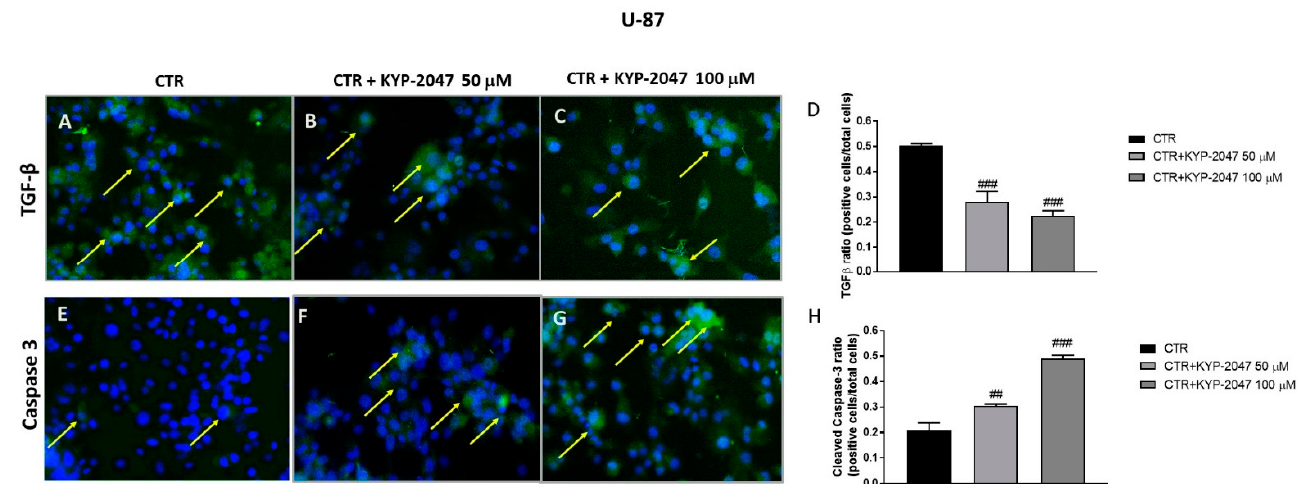
Figure 9. Effect of KYP-2047 on transforming growth factor- β (TGF- β ) and caspase-3 expression in U-87 cells. Immunofluo- rescence assay performed on U-87 cells revealed a marked expression of TGF- β in the control group ( A ), while the treatment with KYP-2047 at the concentrations of 50 µ M and 100 µ M reduced significantly TGF- β expression ( B , C ). Additionally, immunofluorescence staining showed an increase of caspase-3 levels in the groups treated with KYP-2047 at the concen- trations of 50 µ M and 100 µ M ( F , G ) compared to control group ( E ). Data are representative of at least three independent experiments. ( D ) ### p < 0.001 vs. CTR; ( H ) ## p < 0.01 vs. CTR; ### p < 0.001 vs. CTR.